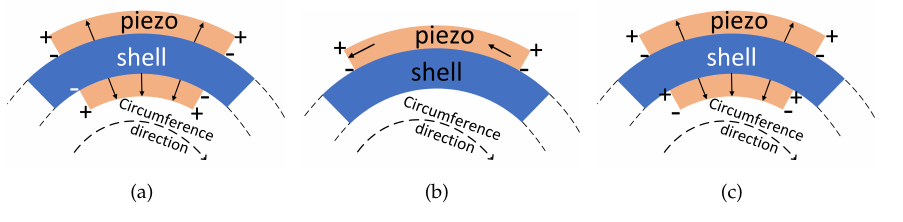
Figure 17. Circuit connection of transducer with radius increasing. ( a ) + − − + ; ( b ) − + ; ( c ) − + − +